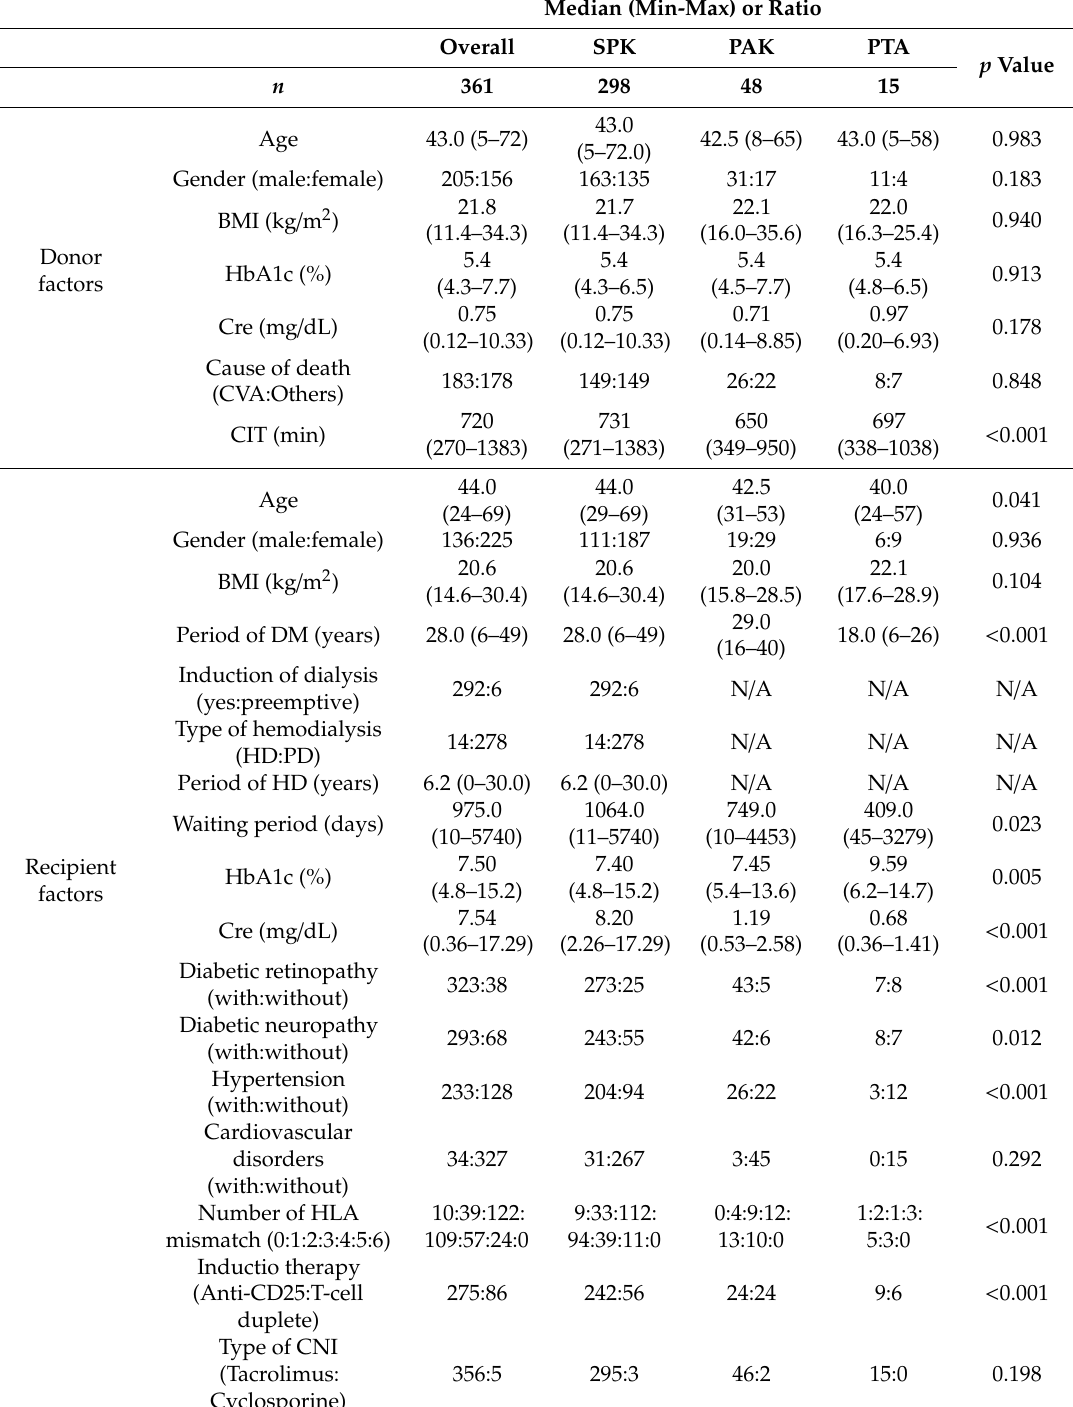
Table 2. Background characteristics of patients at the time of pancreas